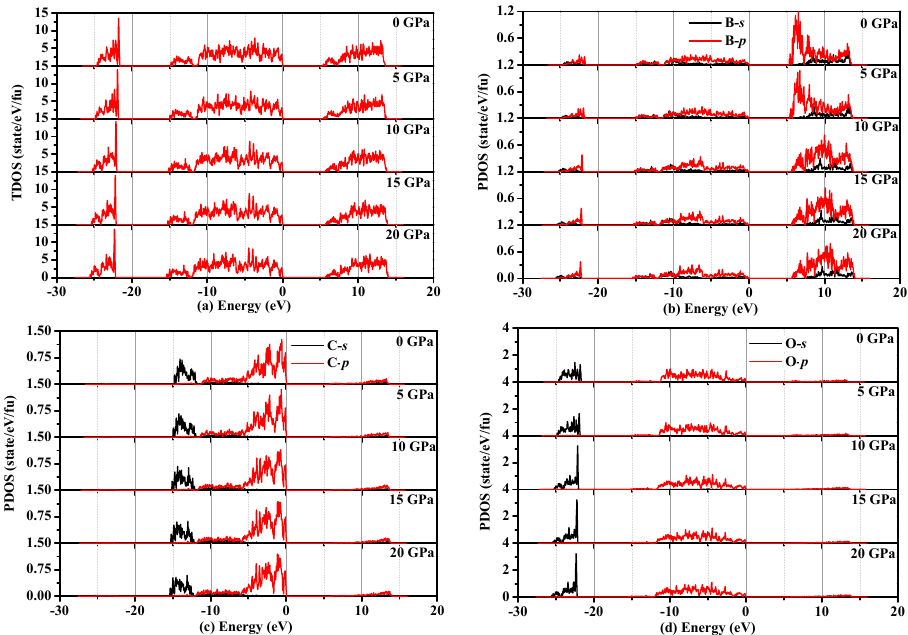
Figure 9 Density of states of B 6 C 2 O 5 under different pressures: total density of states ( a ); partial density of states of B atom ( b ); partial density of states of C atom ( c ); and partial density of states of O atom ( d ).